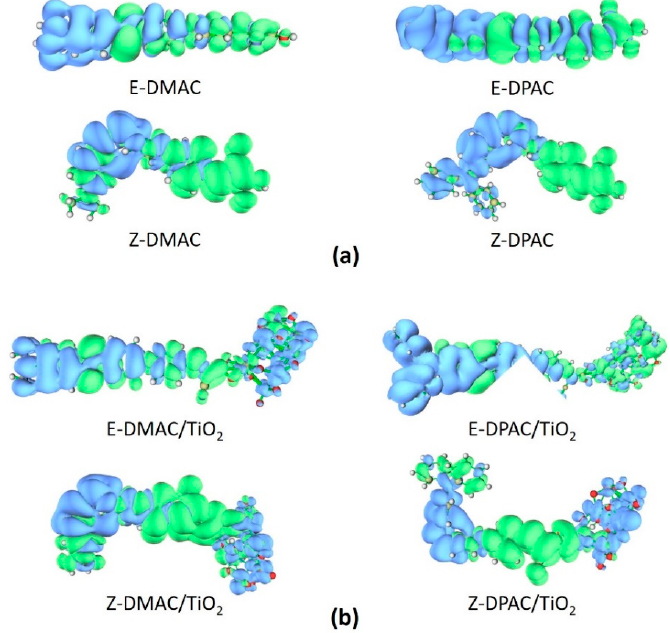
Figure 7. Electron density difference maps for cis and trans isomers of DMAC and DPAC as ( a ) isolated dyes and ( b ) dye/TiO 2 complexes.